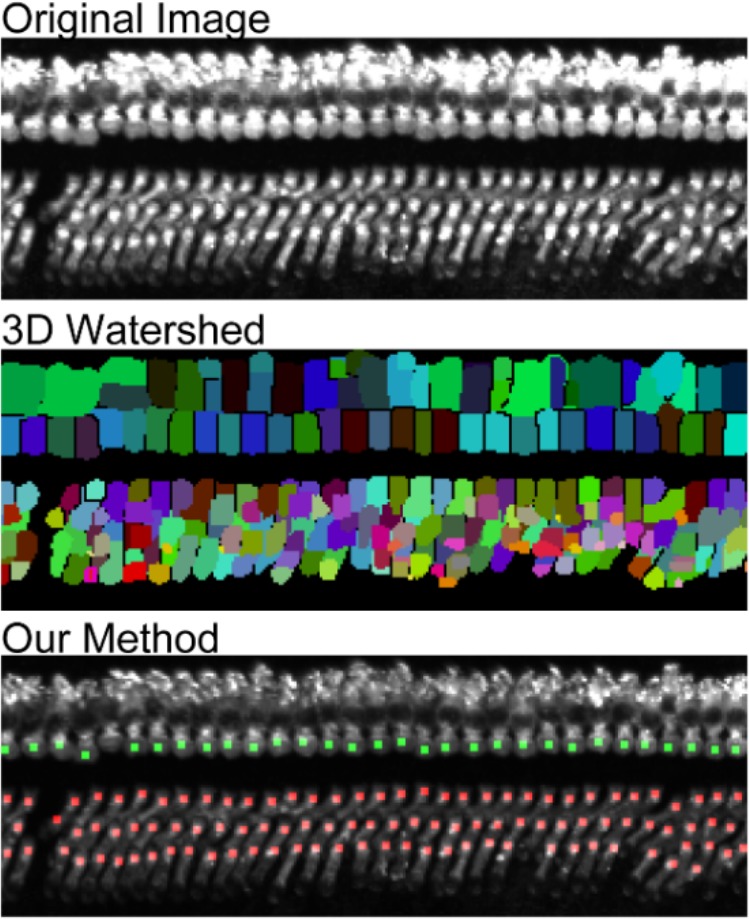
Comparison of 3D watershed and our machine learning based method.There are many duplicate count and false detection with 3D watershed method.